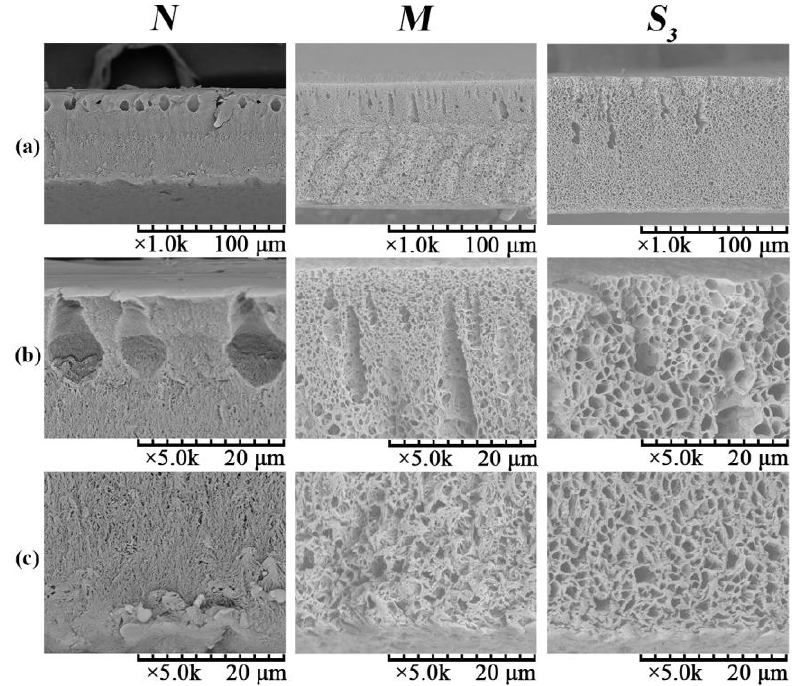
Figure 8. SEM images of membrane cross-section of N , M , S 3 : ( a ) full cross-section; ( b ) cross-section adjacent to the top surface; ( c ) cross-section adjacent to the bottom surface.